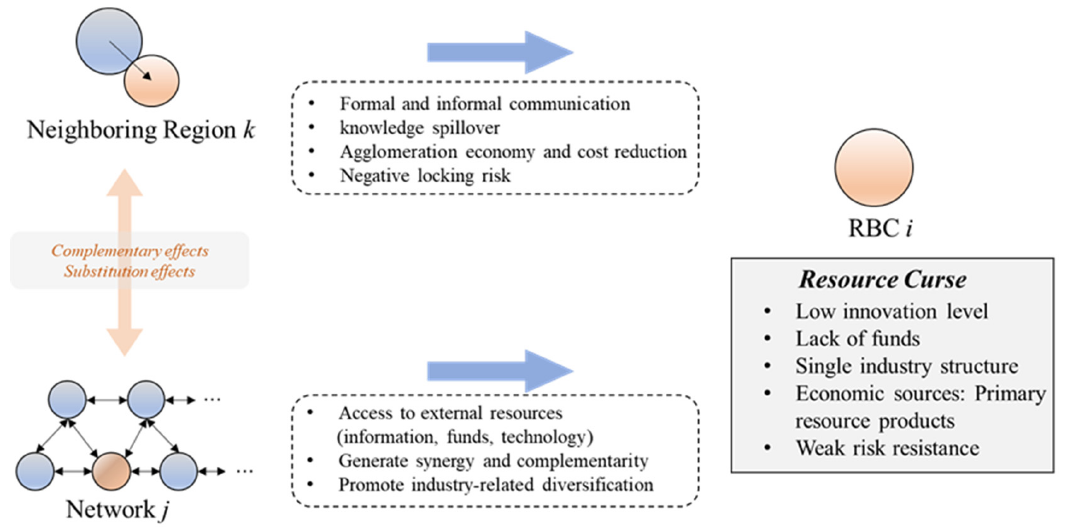
Figure 2. Mechanisms of multi-dimensional proximity for RBCs (Self-drawn by the author).